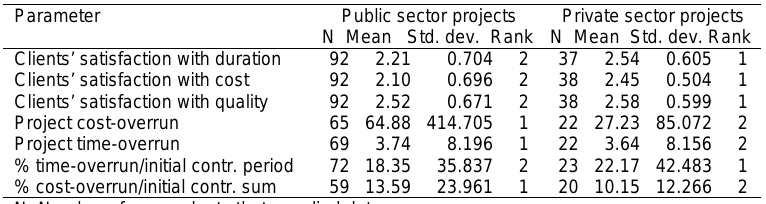
Table 4: Ranking analysis by performance